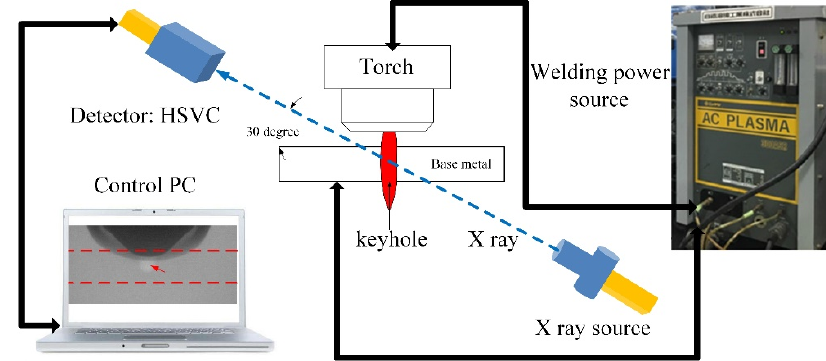
Figure 3. X-ray observation system of the keyhole boundary in digging process of VPPA welding.